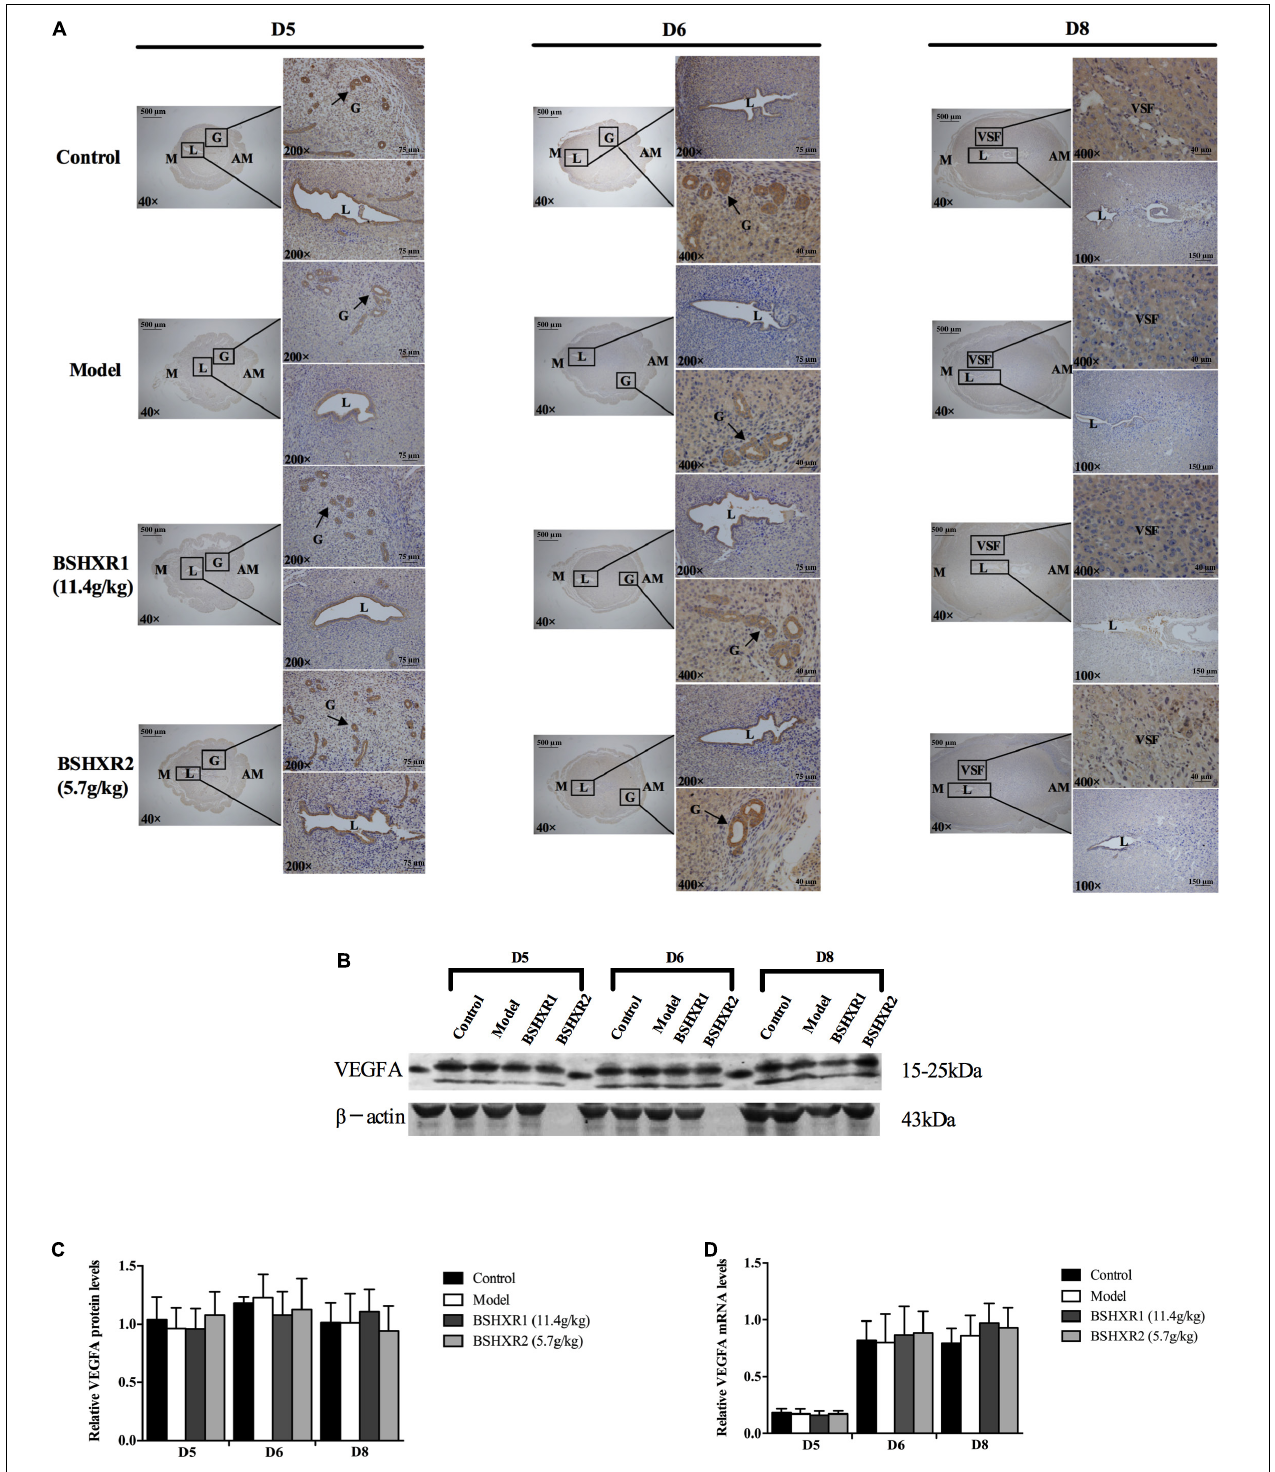
FIGURE 9 | VEGFA expression in the uterus on D5, D6, and D8. (A) Immunohistochemistry of VEGFA in paraffin sections of the uterus. The right pictures are the higher magnification images of the black boxes on the left. Arrow indicates the positive staining. L, lumen; G, gland; M, mesometrial; AM, anti-mesometrial; VSF, vascular sinus folding. Original magnification and scale bar were shown in the pictures. (B) Protein levels of VEGFA in pregnant uterus (remove embryo) by western blot analysis ( n = 3). (C) Quantification of VEGFA protein expression. (D) mRNA levels of VEGFA in pregnant uterus (remove embryo) by qRT-PCR ( n = 5). Data represent mean ± SD. β -actin was used as the